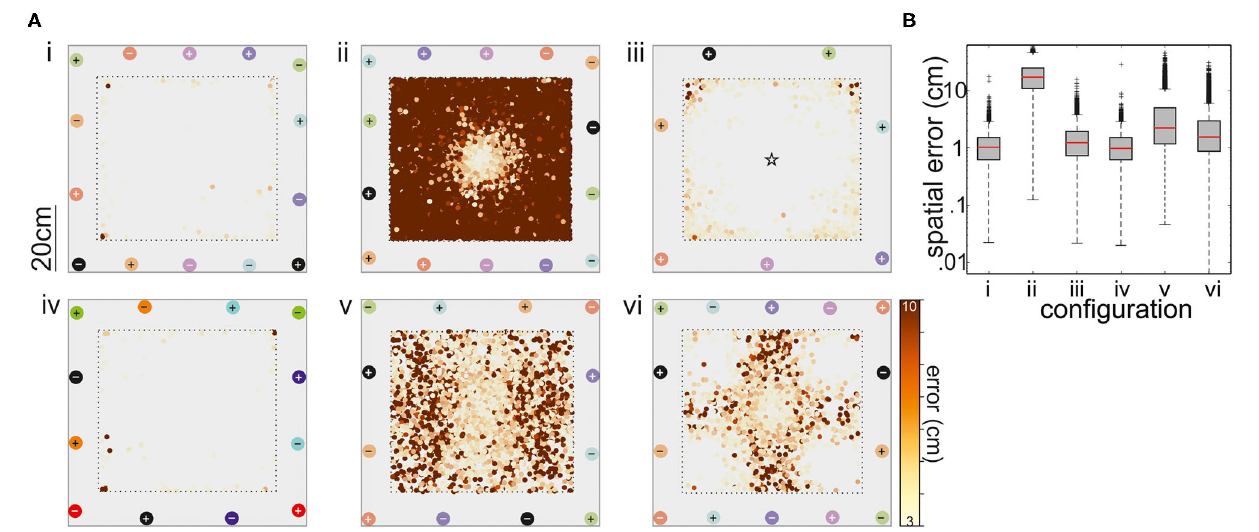
FIGURE 6 | (A) Performance of the tracking with respect to six different electrode configurations. Electrode pairs are marked with different colors, where + corresponds to the positive and – to the negative pole. With the exception of the arrangement shown in (iii) , all recordings were differential (refer to matching colors of electrodes, depicted as circles). In the setup shown in panel (iii), the ground electrode was situated in the middle of the tank. The top view of the arena shows where tracking errors larger than 3cm occurred. The magnitude of these errors is color coded (see bar). (B) Box-and-whisker plots of the spatial error for the six electrode configurations. The configurations 1, 3, and 4 had the best performance and configuration 1 was further used in the behavioral experiments on dyadic interactions (see text for details).